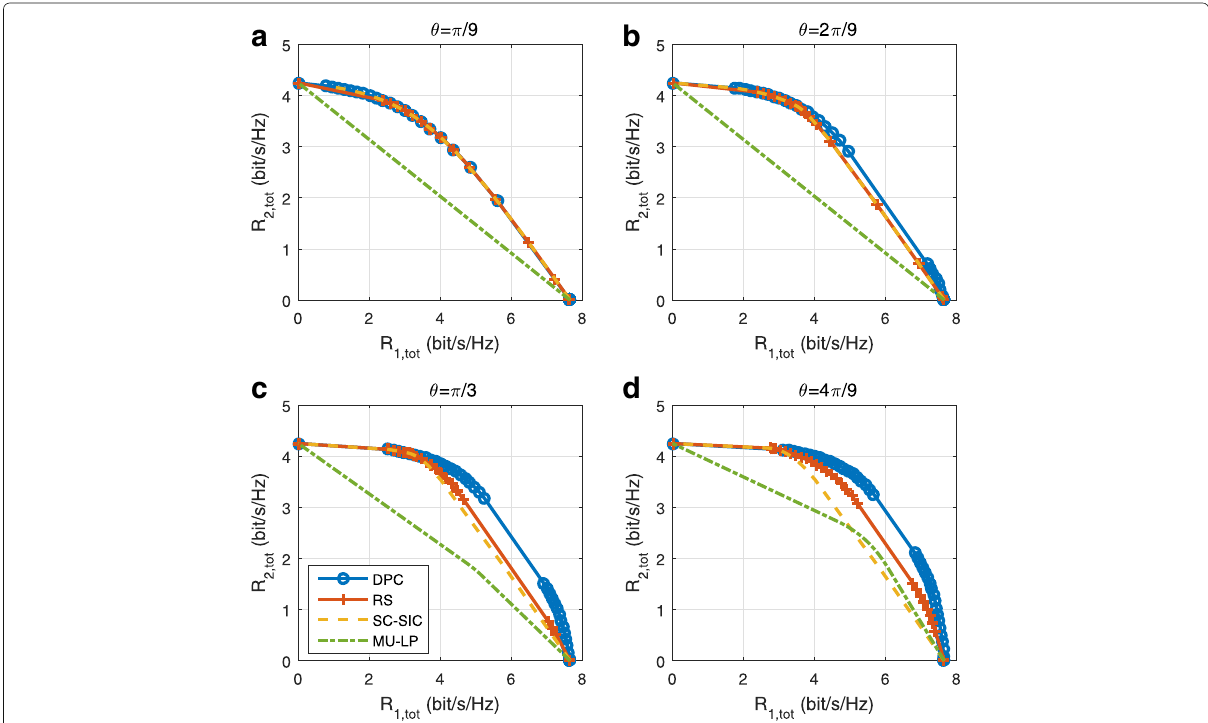
Fig. 10 Achievable rate region comparison of different strategies in perfect CSIT, γ = 0.3, N t = 2, SNR = 20 dB. a θ = π/ 9. b θ = 2 π/ 9. c θ = π/ 3.